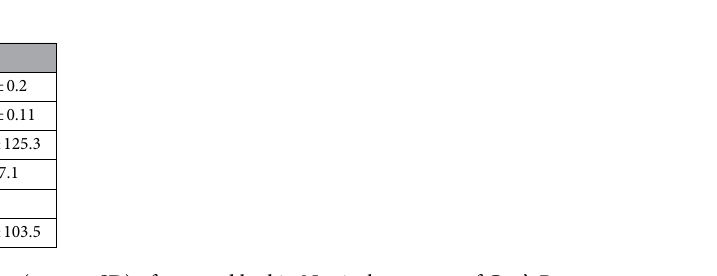
Table 2. Water and soil nutrients (mean ± SD) of seaweed bed in Nuniachara coast of Cox’s Bazar.